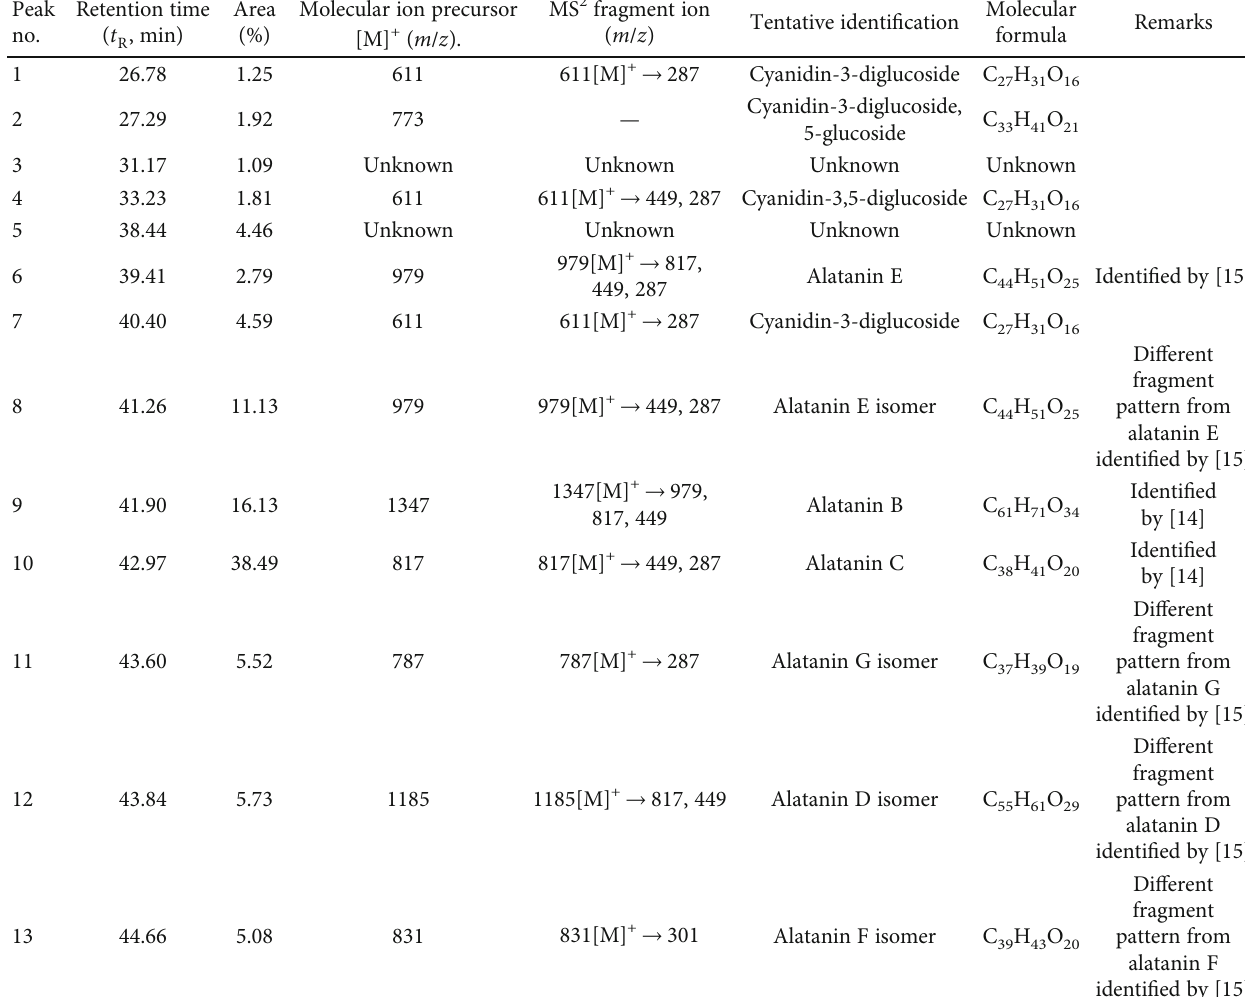
Table 1: Mass spectrometric data and tentative identi fi cation of anthocyanins in the KKFCRC yam EtOH extracts. Peak